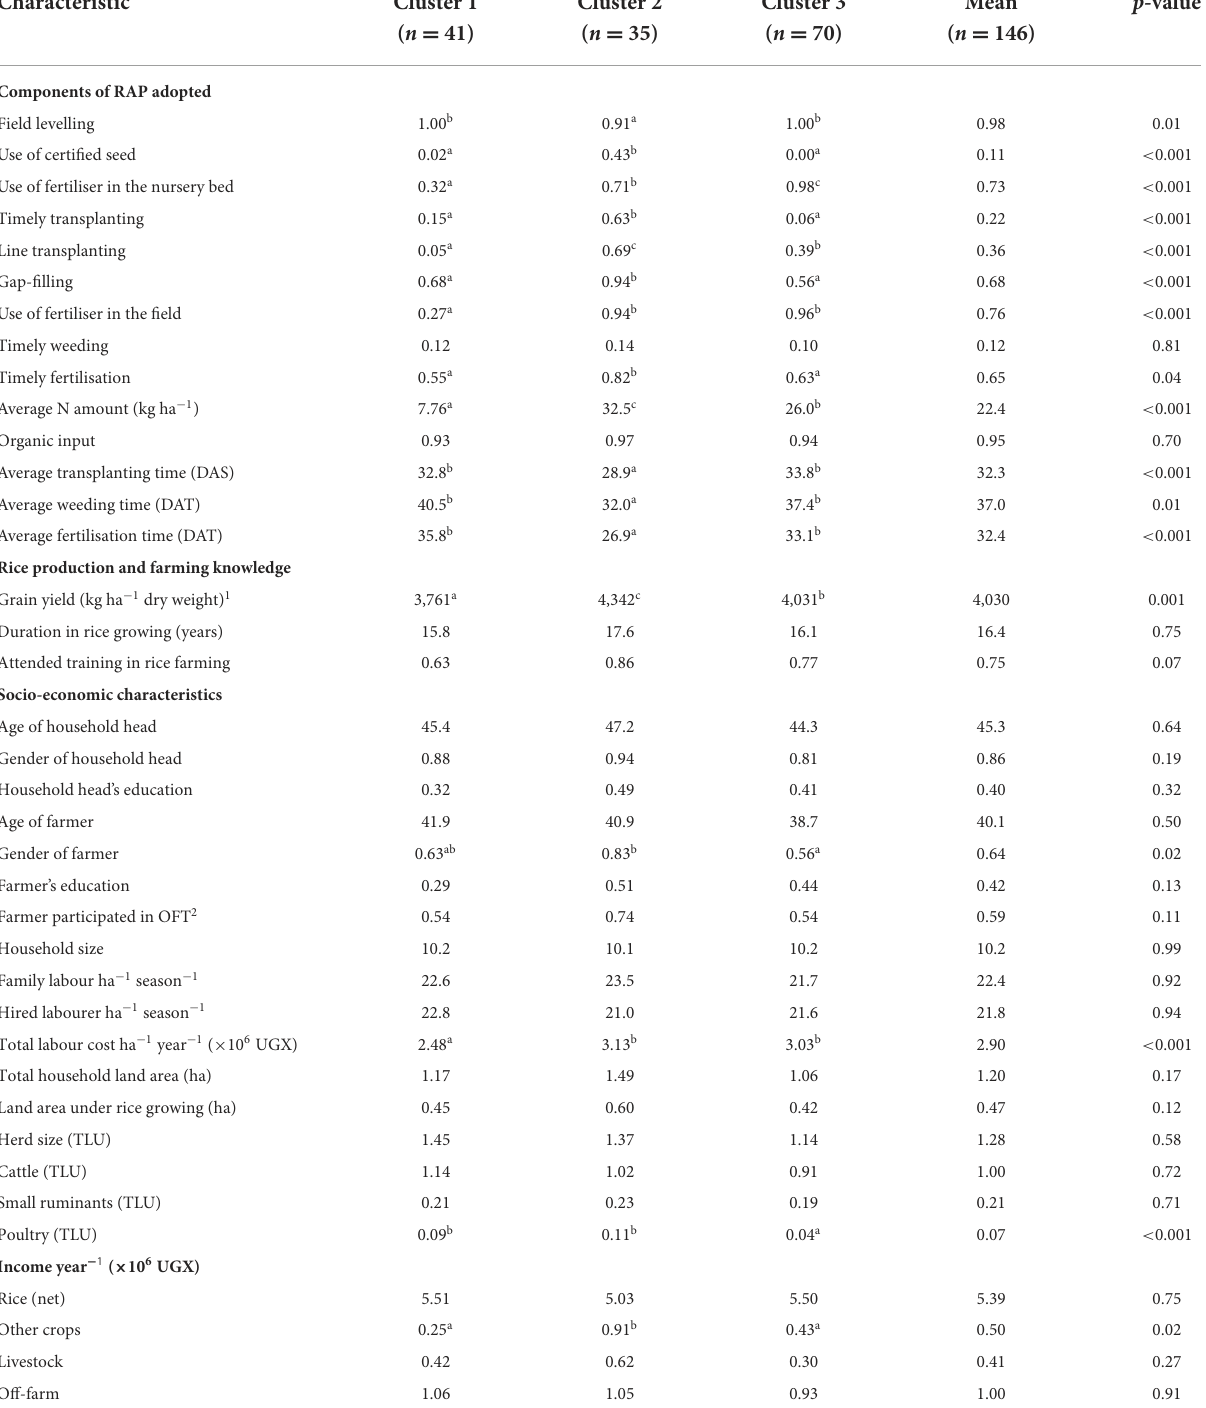
TABLE 6 Characteristics of farm households and the identified clusters including the p -value of one-way analysis of variance of differences between farm types. Characteristic Cluster 1